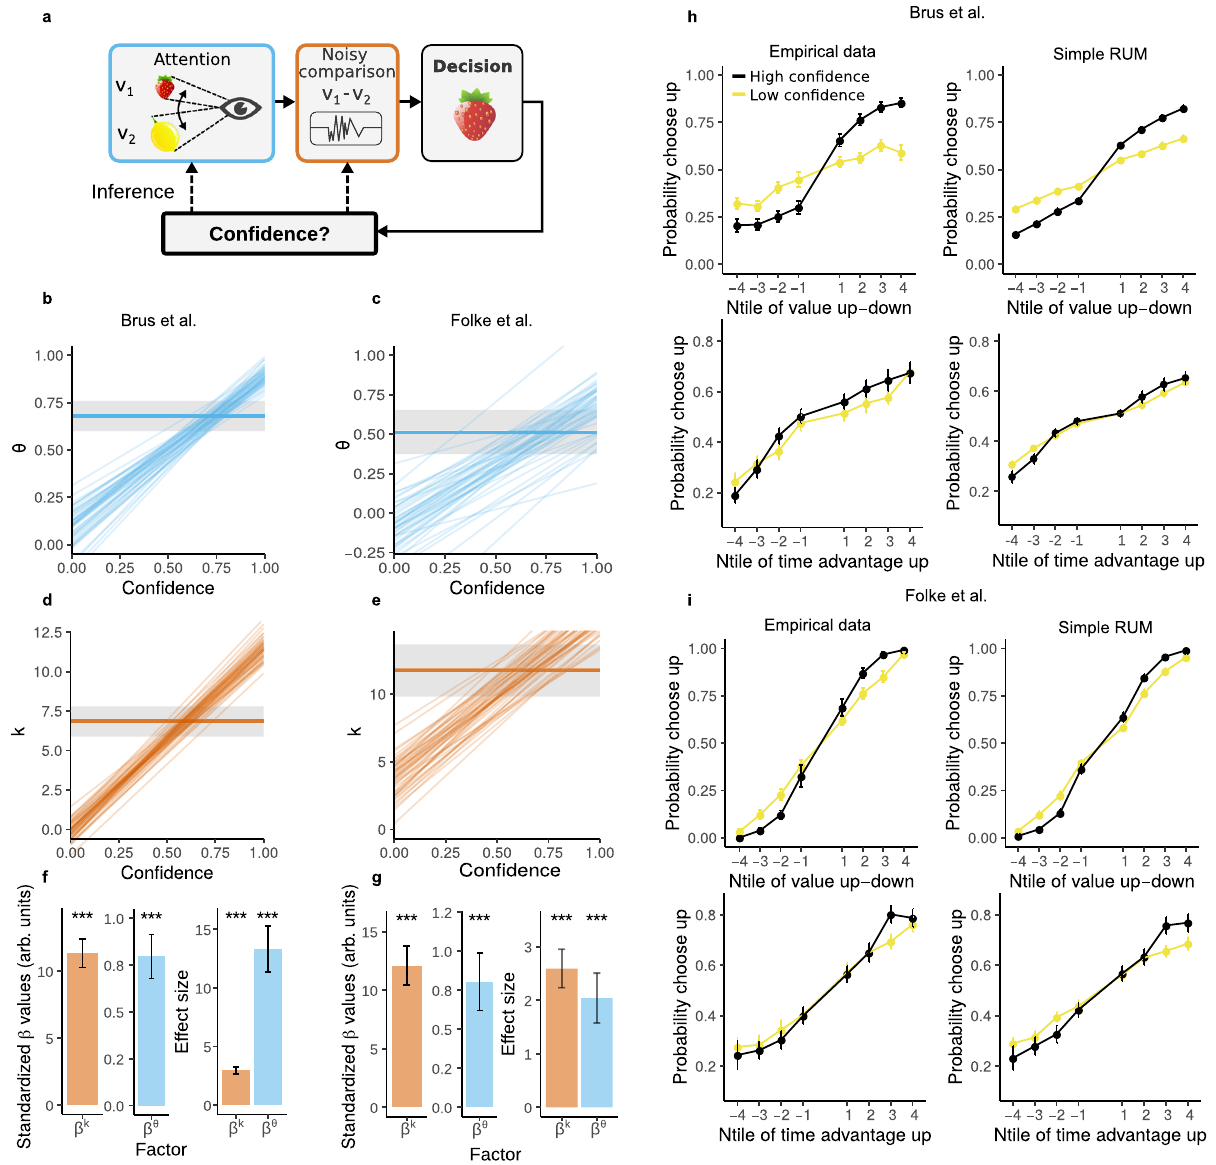
Fig. 4 The RUM decision model. a Sketch of the simple RUM decision model, color-coded to match the graphs. Observers infer the value of the food items by looking back and forth between choice alternatives. The subsequent comparison process is noisy. We investigate how con fi dence ratings in fl uence trial-to-trial fl uctuations of attentional factors and the evidence gain. b , d Comparison of parameter estimates of two alternative RUMs: a RUM with agent-speci fi c estimates of k and θ and a RUM that allows for trial-to-trial fl uctuations of k and θ . b) the median of the posterior estimate of θ of the agent-speci fi c RUM is indicated by the horizontal blue line, the shaded grey area indicates the 95% con fi dence interval. The diagonal blue lines represent 100 random samples of the posterior distribution of how θ changes with con fi dence in the RUM allowing for trial-to-trial fl uctuations. Remarkably, θ changes over its full range as a function of con fi dence. d) the same as b, but for k . f Left: standardized posterior estimates of the relationship between con fi dence and k and θ . Error bars indicate the mean posterior estimate of the standard deviation. Both β k and β θ are signi fi cantly bigger than zero with P <0.001. Right: effect sizes of the results shown on the left. Error bars indicate the standard deviation of the posterior estimates of the mean of the effect size. Both the effect sizes of β k and β θ are signi fi cantly bigger than zero with P <0.001. P -values are based on the highest density interval of the posterior estimates. h Left column: the empirical probabilities of choosing the upper item; up: as a function of value difference; down: as a function of the difference in dwell time. Right column: the same as left but for the predicted probabilities of choosing the upper item by the simple RUM. The trials are median split in high/low con fi dence. Value difference and dwell time difference are split into eight groups of equal size. Data are presented as mean values±SEM. c , e , g , i ) Same as b , d , f , h , but for the data of Folke et al. For the Brus et al. dataset n = 33 independent participants, for Folke et al. n = 28 independent participants. Source data are provided as a Source Data fi